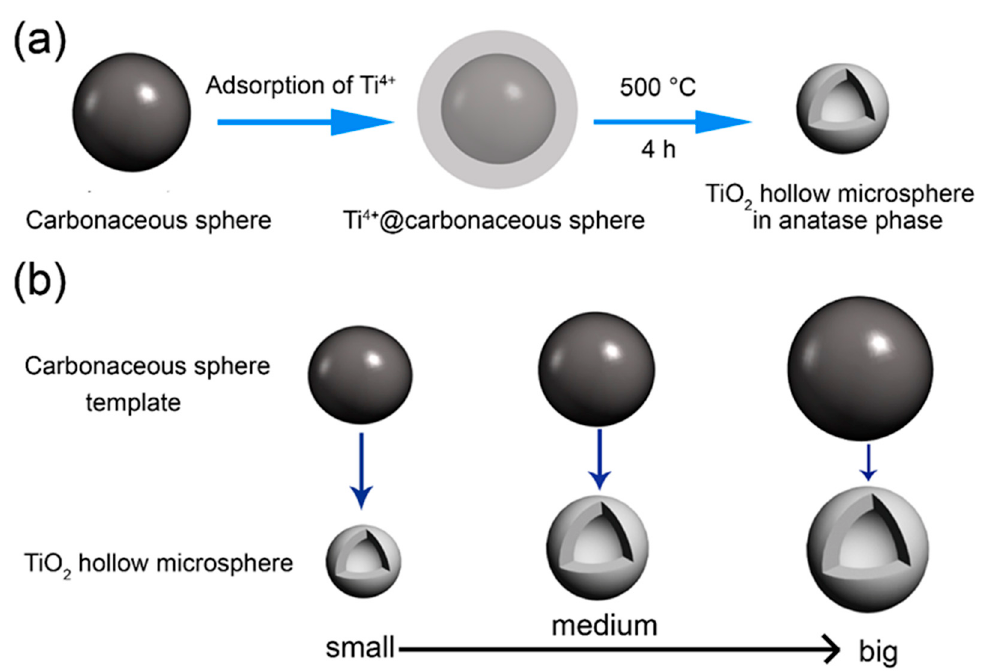
Figure 3. ( a ) The formation illustration of TiO 2 HMS by CS template method; ( b ) the mechanism of size controllable synthesis of TiO 2 HMS by CS template method.